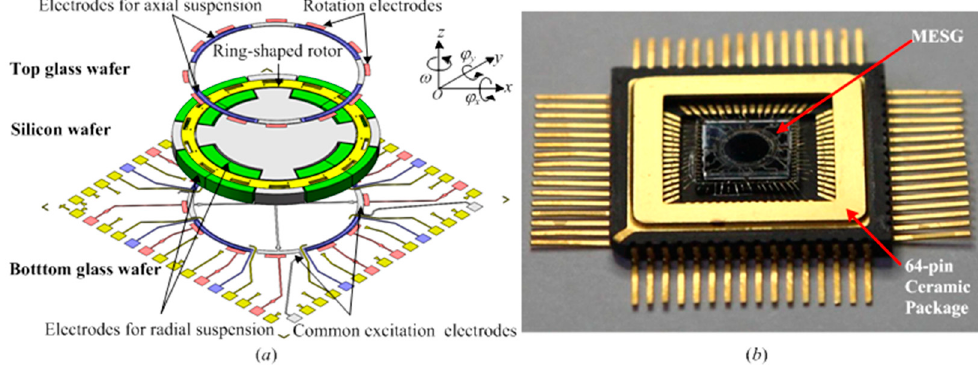
Figure 1. Micromachined dual-axis spinning-rotor gyroscopes (MESG): ( a ) the exploded view of the device and ( b ) a fabricated device.